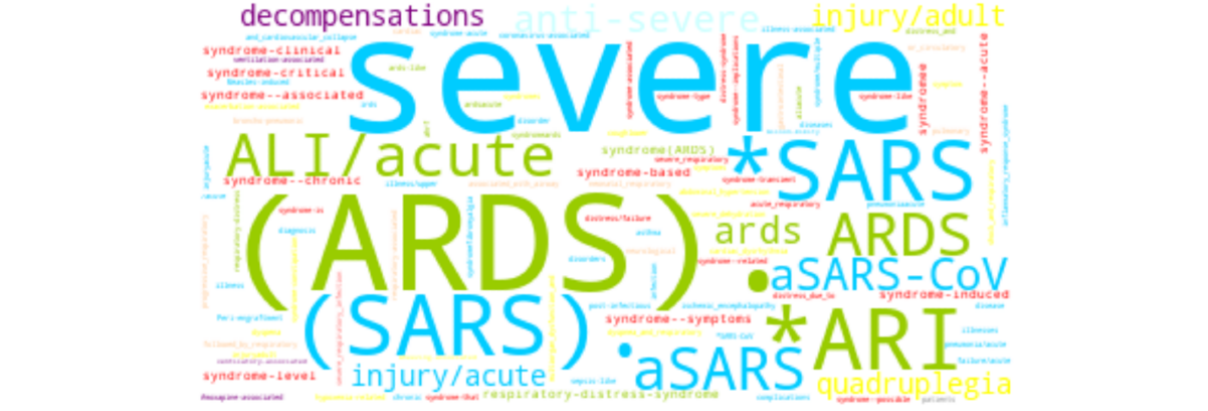
Figure 7. Word cloud depicting each returned term for “acute respiratory distress syndrome.” Colors correspond to semantic class types. ALI: acute lung injury; ARDS: acute respiratory distress syndrome; ARI: acute respiratory infection; SARS: severe acute respiratory syndrome; SARS-CoV: severe acute respiratory syndrome–related